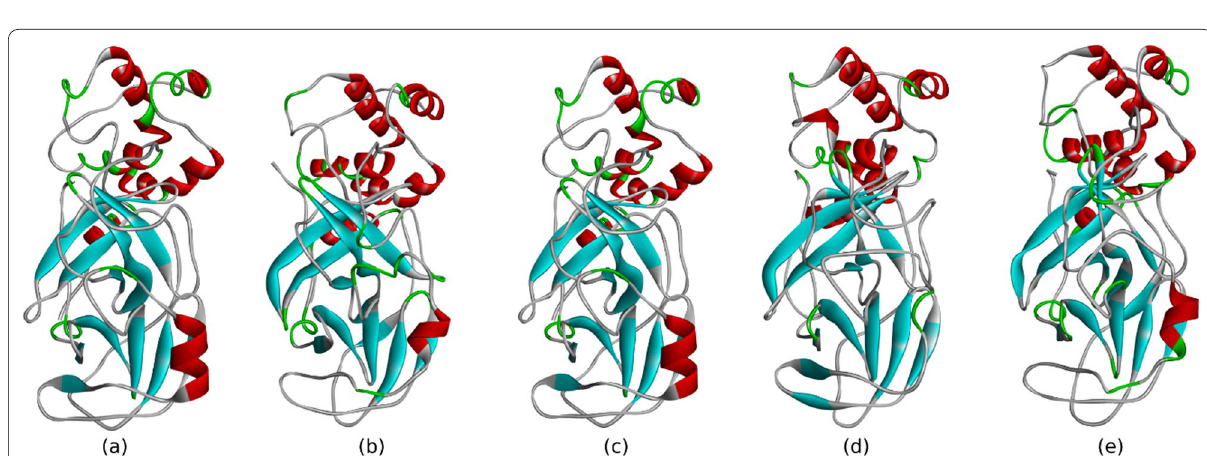
Fig. 6 Stable protein structures of a taxifolin 3-O-α-arabinopyranose, b quercetin 3-O-glucose, c quercetin 3 ′ -glucoside, d rutin, and e resemdivir, generated following molecular dynamics